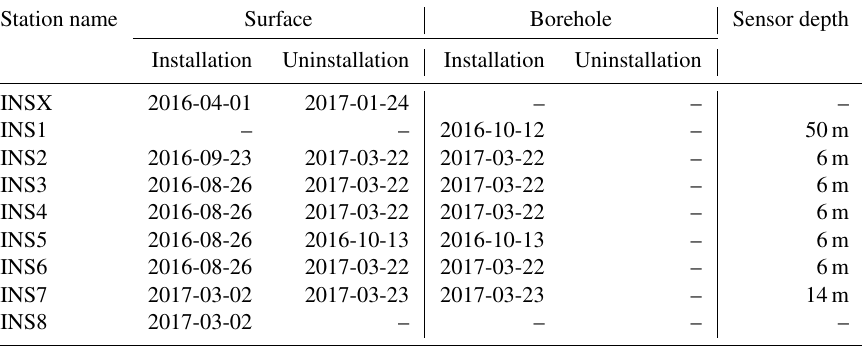
Table 2. Position of the broadband sensors during time for each station with the indication of the sensor depth when it is installed in the